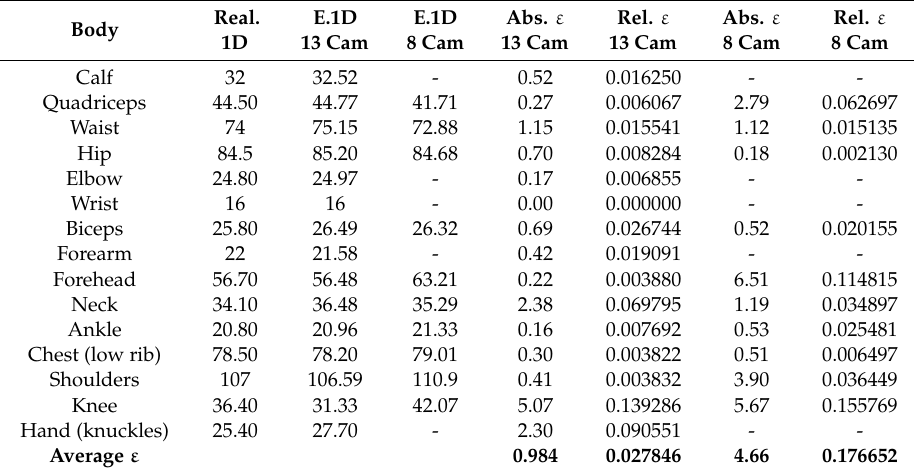
Table 6. Real body part perimeter measurements (R.1D) with both 13- and 8-camera systems, and their estimates (E.1D) in cm. Their relative and absolute errors.